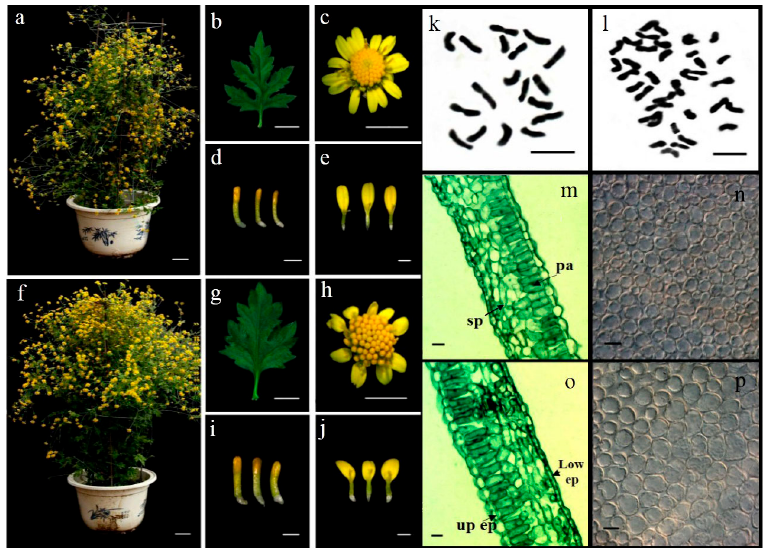
Figure 1. Morphology and chromosome number of diploid and tetraploid Chrysanthemum lavandulifolium: ( a – e , k , m , n ) diploid plant, leaf, inflorescence, tubular florets, ligulate florets, anatomical structure of leave, cell of palisade tissue first layer, and number of chromosomes of diploid plant; and ( f – j , l , o , p ) tetraploid plant, leaf, inflorescence, tubular florets, ligulate florets, anatomical structure of leave, cell of palisade tissue first layer, and number of chromosomes of tetraploid plant. up ep, upper epidermis, low ep, lower epidermis, sp, spongy tissue, pa, palisade tissue. ( a , f ) bars = 5 cm; ( b , c , g , h ) bars = 10 mm; ( d , e , i , j ) bars = 2 mm; ( m , o ) bars = 40 μ m; ( n , p ) bars = 20 μ m; and ( k , l ) bars = 10 μ m.